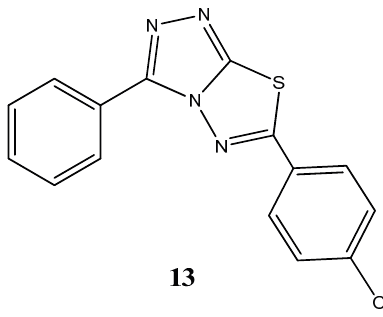
Figure 8. Chemical structure representation of synthetized triazolo[1,3,4]thiadiazole derivative, 6-(4-chlorophenyl)-3-(pyridin-4-yl)-[1,2,4]triazolo[3,4- b ], with proven antiproliferative activity, with superior selectivity for gastric cancer cell lines